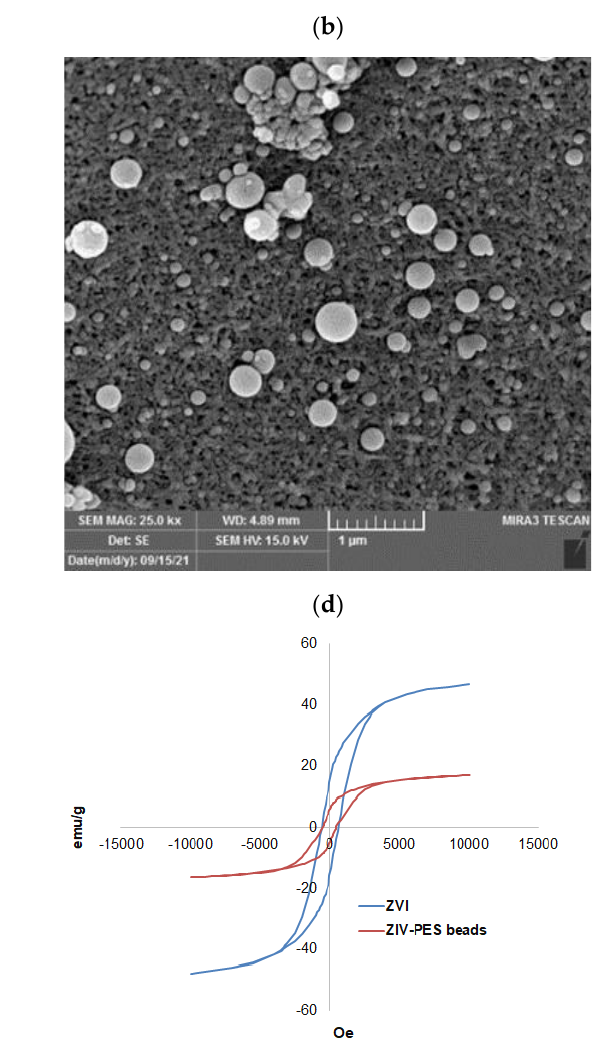
Figure 4. SEM images of ( a ) microbead magnification 5 kx and ( b ) surface of PES/ZVI beads magnification 25 kx. ( c ) EDX spectra of PES/ZVI beads. ( d ) VSM magnetic hysteresis loop for plain ZVI and PES/ZVI